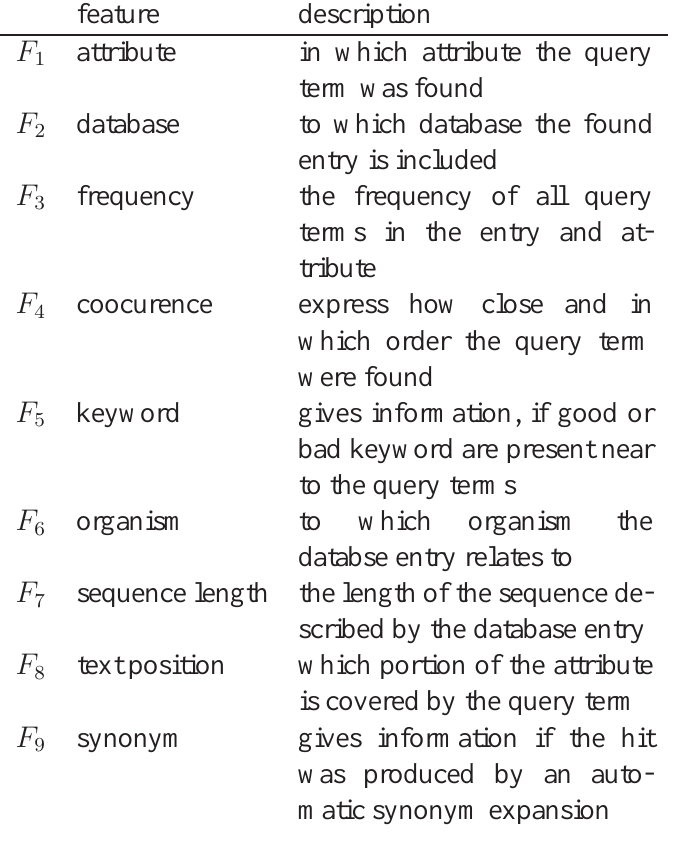
Table 1: Overview of the LAILAPS feature